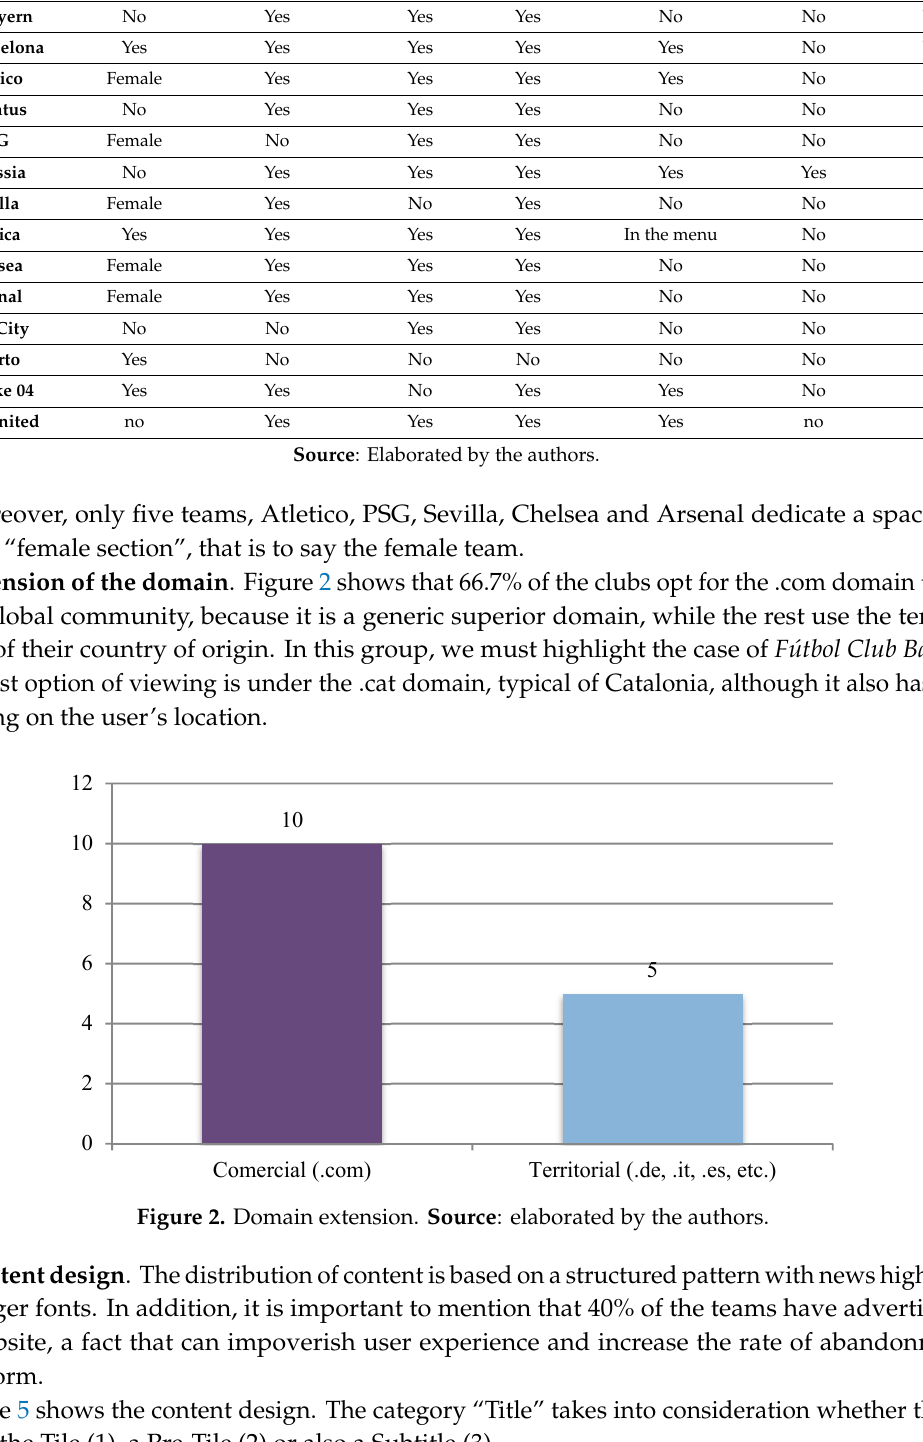
Table 5. Content design and type.